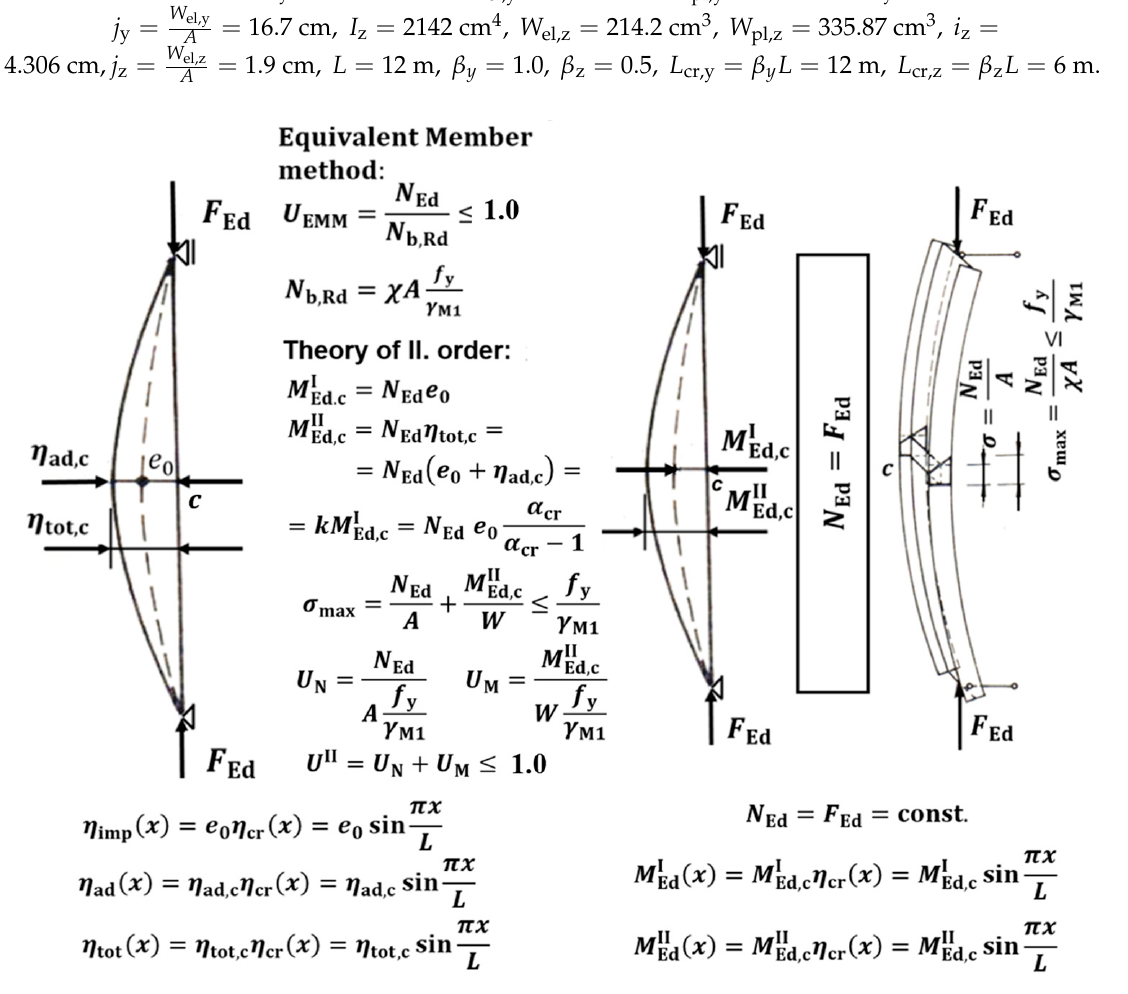
Figure 2. Verification of the compressed member supported by hinges on member ends by two methods. Amplitudes: e 0 of the equivalent geometrical initial imperfection η init ( x ) ; η ad,c of the additional deformation η ad ( x ) ; and η tot,c of the total deformation η tot ( x ).